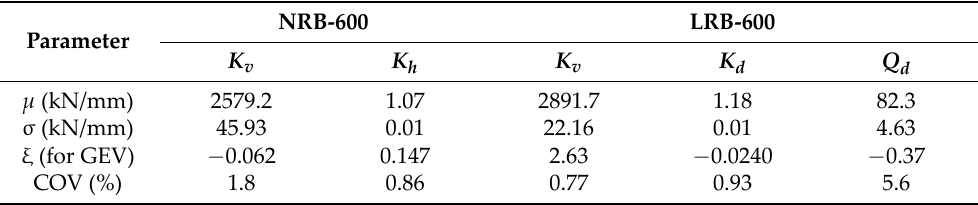
Table 9. Parameters of the probabilistic distribution of the mechanical behaviors. NRB‑600 LRB‑600 Parameter K